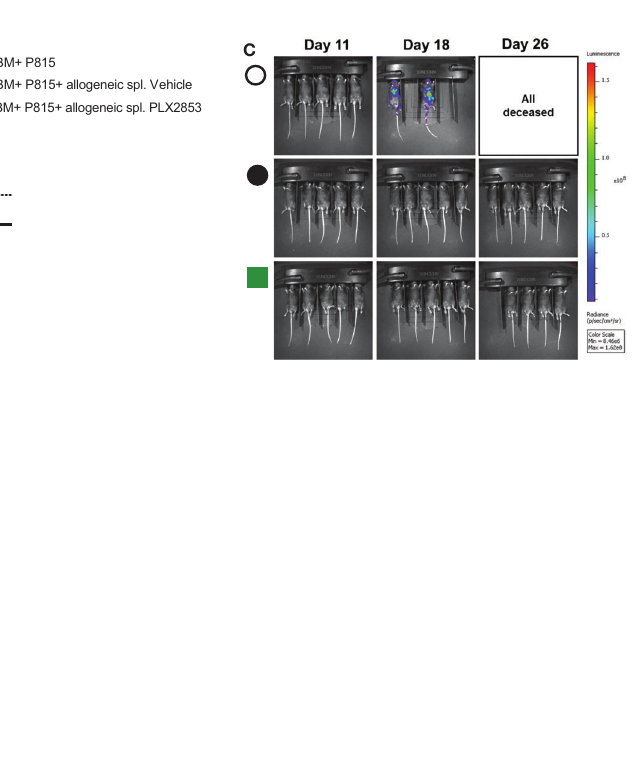
FIGURE 4 | BET inhibitor PLX2853 retains GVL activity in vivo . (A) Luciferase-transduced P815 cells were injected into lethally irradiated F1 recipients along with TCD-BM or TCD-BM+ allogeneic CD45.1 B6 splenocytes (n=15-18 per group). Recipients of allogeneic splenocytes were treated with vehicle or PLX2853. Survival curve. Data combined from two independent transplant experiments. (B, C) Whole-body bioluminescent signal intensity of recipient mice (n= 5 per cohort). Mice were imaged on indicated days. Average radiance expressed as mean ± SD. Data shown is representative of one of two independent transplant experiments. (D) Percentage GFP positivity. Splenocytes were isolated at time of death and P815 leukemic burden evaluated by GFP positivity using fl ow cytometry. (E) Splenocytes from vehicle and PLX2853 cohort transplant recipients were analyzed by fl ow cytometry to evaluate IFN g secretion and CD107a expression on CTL. (F) Representative contour plots. **p < 0.01, ****p < 0.0001. NS, not signi fi